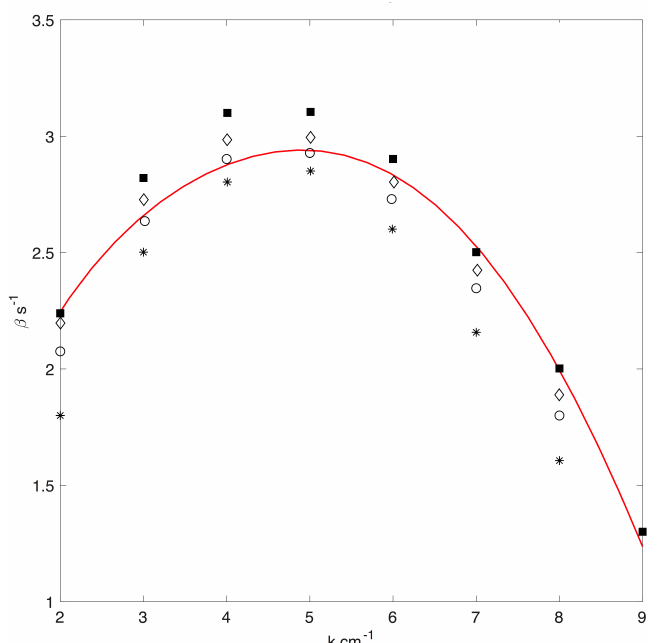
Figure 4. Colour online. Validation of the numerical method, for u ∗ = 24.8 cm s − 1 , using the lin-log velocity profile in the air and the exponential profile in the water. The energy growth rate β is plotted against the wavenumber k . Present results: solid line (red). [10]: (cid:5) . [4]: (cid:4) . [7]: ∗ . [9]: ◦